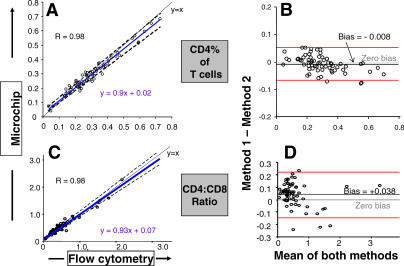
Methods Comparison and Correlation Studies for CD4 Percentages of Total T Cells and CD4:CD8 Ratios in 67 Human Subjects(A and B) CD4 percentages of total T cells and (C and D) CD4:CD8 ratios in 67 human participants, including 61 adults and six children. In Passing–Bablok correlation plots (A and C), solid black lines indicate identity, blue lines indicate the observed correlations, and dashed black lines indicate 95% confidence limits. Correlations for CD4 percentages of total T cells (r = 0.98, p < 0.0001) and CD4:CD8 ratios (r = 0.98, p < 0.0001) are shown. For Bland–Altman methods comparison plots (B and D), notations are as described in Figure 6 caption.